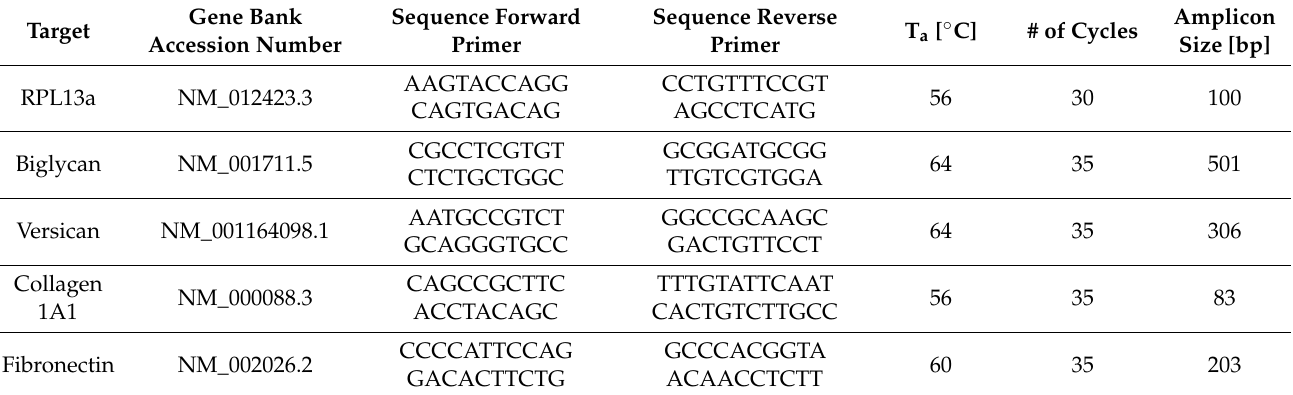
Table 1. List of primers, their sequences, and the corresponding PCR